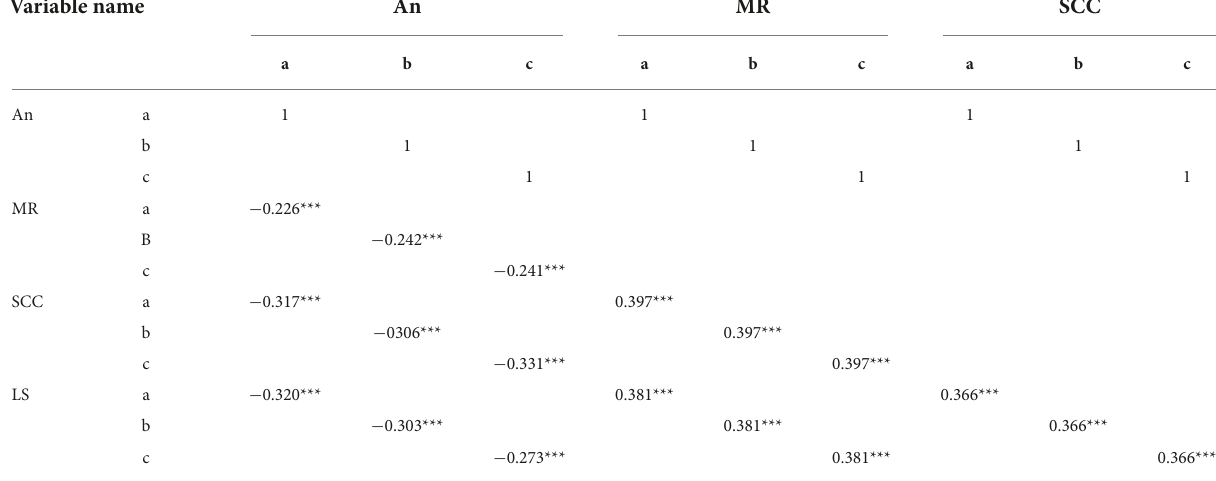
TABLE 2 The correlation analysis among variables.